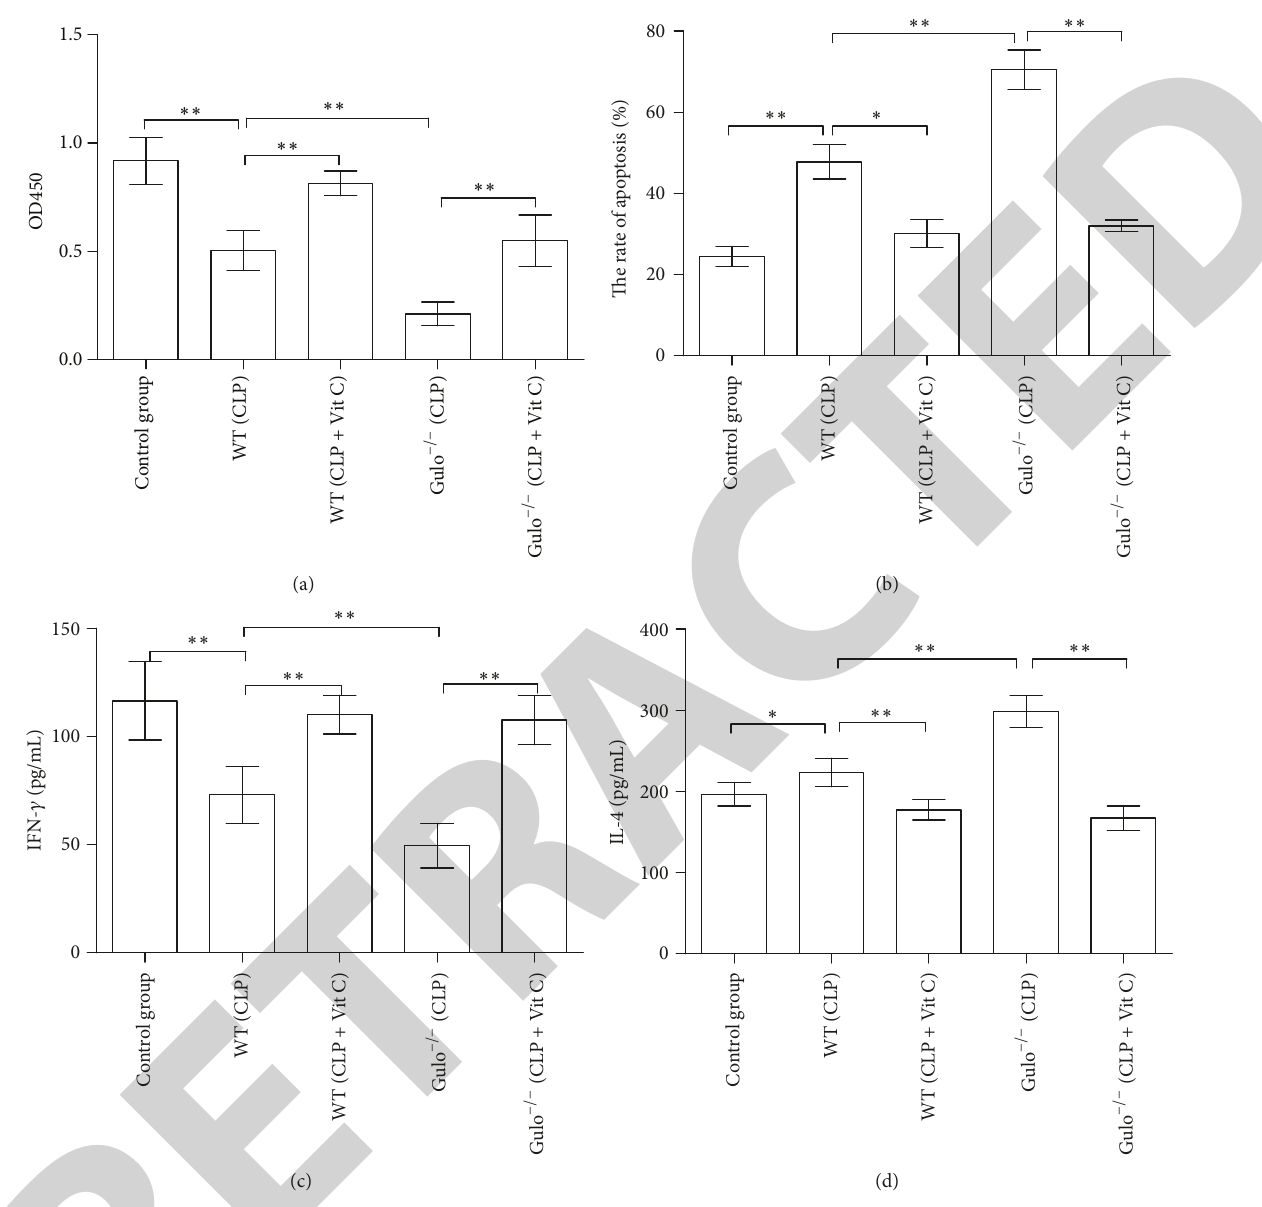
Figure 3: The impact of parenteral Vit C on the immunosuppressive function of CD4 + CD25 + Tregs. The parenteral Vit C inhibited the immunosuppressive function of CD4 + CD25 + Tregs which upregulated the proliferative response (a) and release of IFN- 𝛾 (c) but significantly downregulated the apoptotic rate (b) and release of IL-4 (d) of splenic conventional CD4 + CD25 − T cells. Data were represented as mean ± standard deviation (SD) and analyzed by software SPSS 17.0 with one-way ANOVA, 𝑛 = 4 per group, ∗ 𝑝 < 0.05 or ∗∗ 𝑝 < 0.01